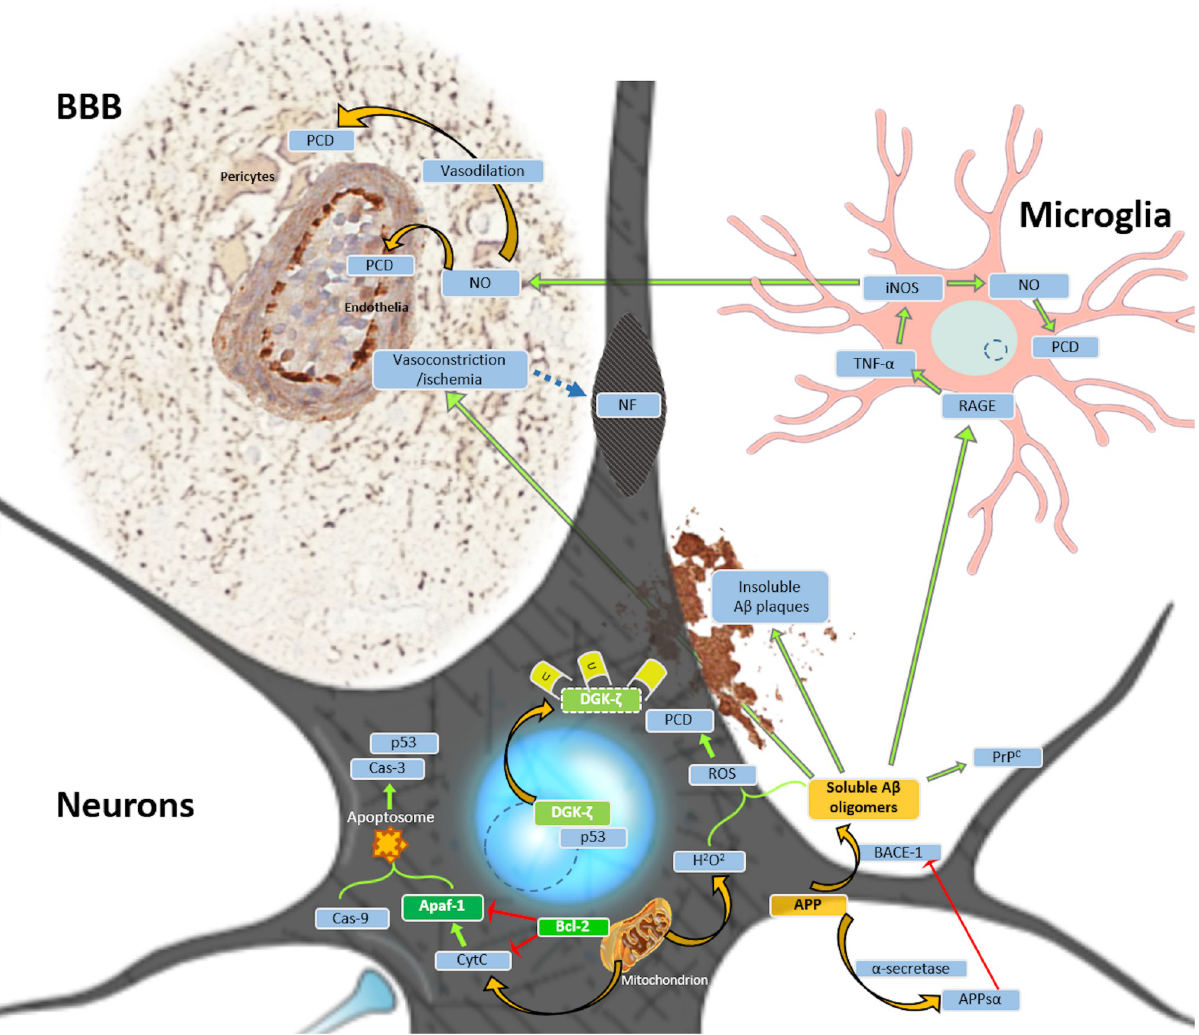
Fig 5. Relevant biological roles of the implemented biomarkers protein in programmed cell death PCD (PCD; green highlight) and A β -associated toxicity (orange highlight) as referred to in the main text. Light blue circles—nuclei. Dashed line circles—nucleoli. Orange arrows—translocation and transformation of molecules/processes. Green arrows—activation or induction of molecules. Red arrows—inhibition of molecules. Blue highlight— interacting molecules. Blue dashed arrow: Association between focal ischemia and proteolysis of cytoskeletal neurofilaments (NF), leading to the development of spheroids. Abbreviations: APPs α —soluble APP α ; BACE-1—Beta-site APP Cleaving Enzyme 1; BBB—blood brain barrier; Cas— caspase; iNOS—inducible nitric oxide synthase/NOS II; NO—nitric oxide; p53—(tumor) protein 53; Prp C —cellular prion protein; RAGE—Receptor for Advanced Glycation End Products; U—ubiquitin (degrades cytoplasmic DGK- z ). Astrocytes are omitted from this figure for simplification, though they closely interact with both neurons and microglia under both physiological and pathological